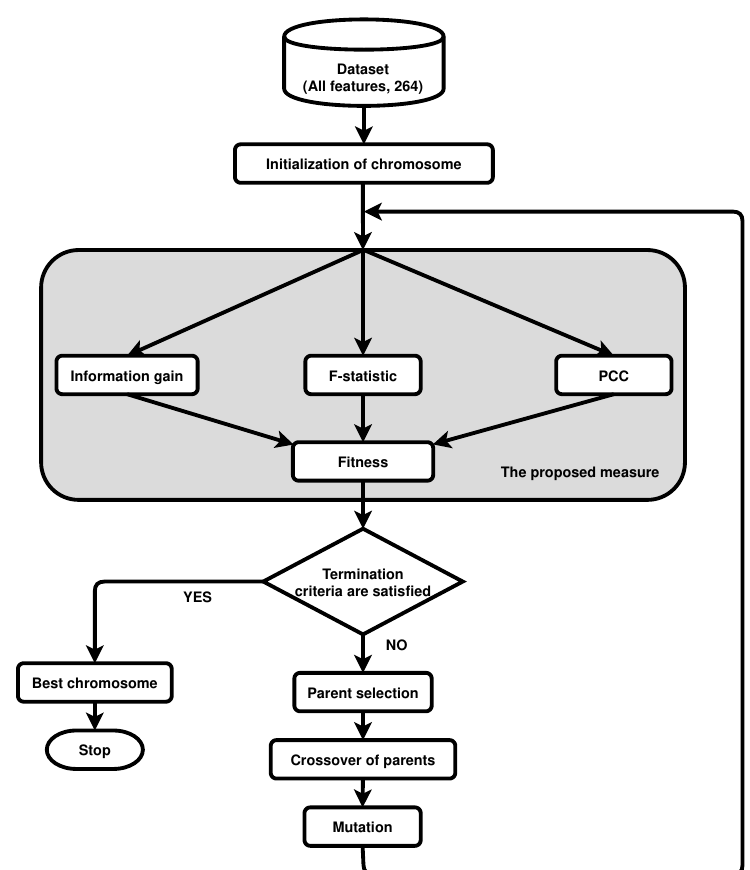
Figure 2. Flowchart of our genetic